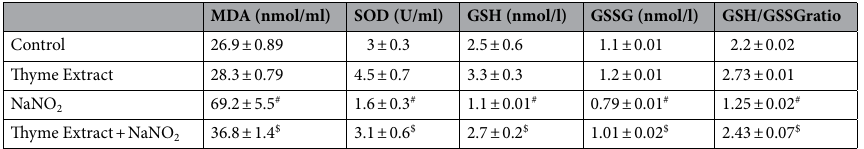
Table 5. Protective effects of Thymus vulgaris extract against NaNO 2 induced alterations in antioxidant activity in mice. Values are means ± SEM for 7 different mice per each experiment. Values are statistically significant at # p < 0.05 versus control and thyme extract groups. $ p < 0.05 versus NaNO 2 .